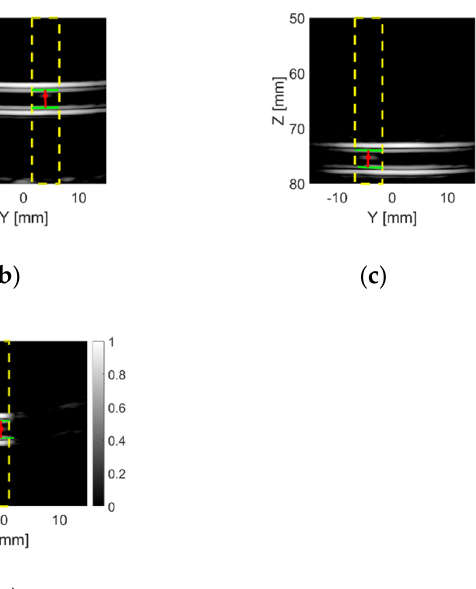
Figure 16. TFM image of ( a ) the 55 mm phantom, ( b ) the 65 mm phantom, ( c ) the 75 mm phantom, ( d ) the Angle V phantom and ( e ) the Angle H phantom with the TMM particle placed inside the tube from the CECAT.